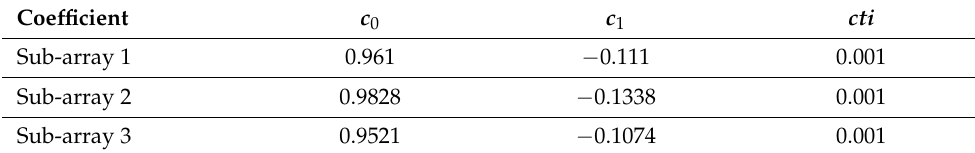
Table 4. Empirically identified parameters used to predict DC current using sandia model. Coefficient